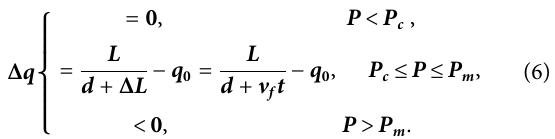
Figure 6C . The numbers of reperfusion RBCs can